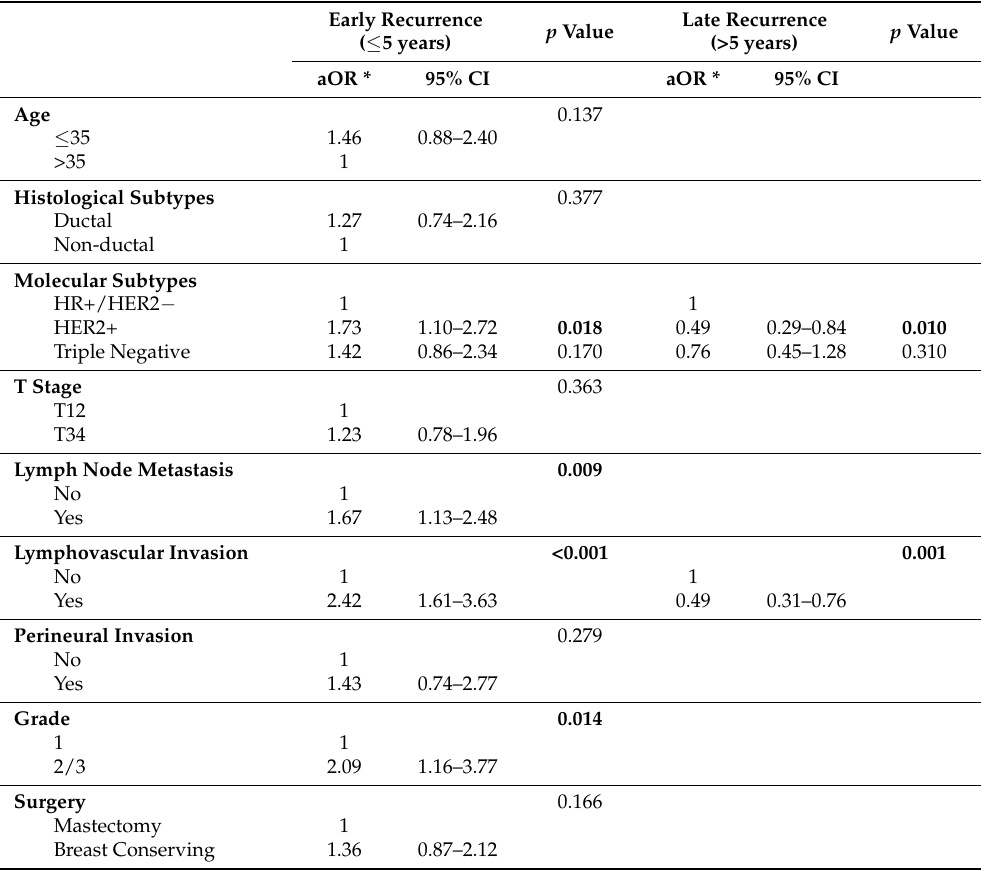
Table 3. Multivariate analysis of risk factors for early and late